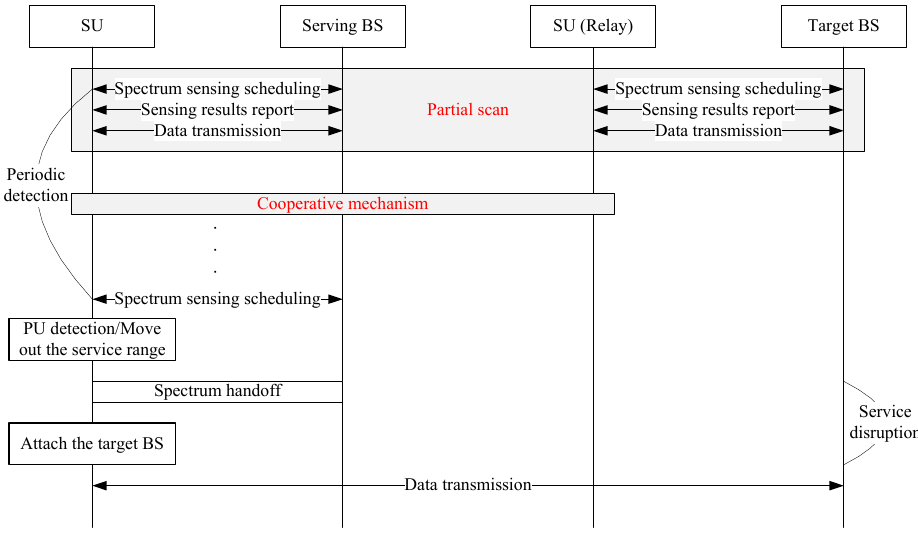
Figure 7. Cooperation-assisted with fast scan mechanism.